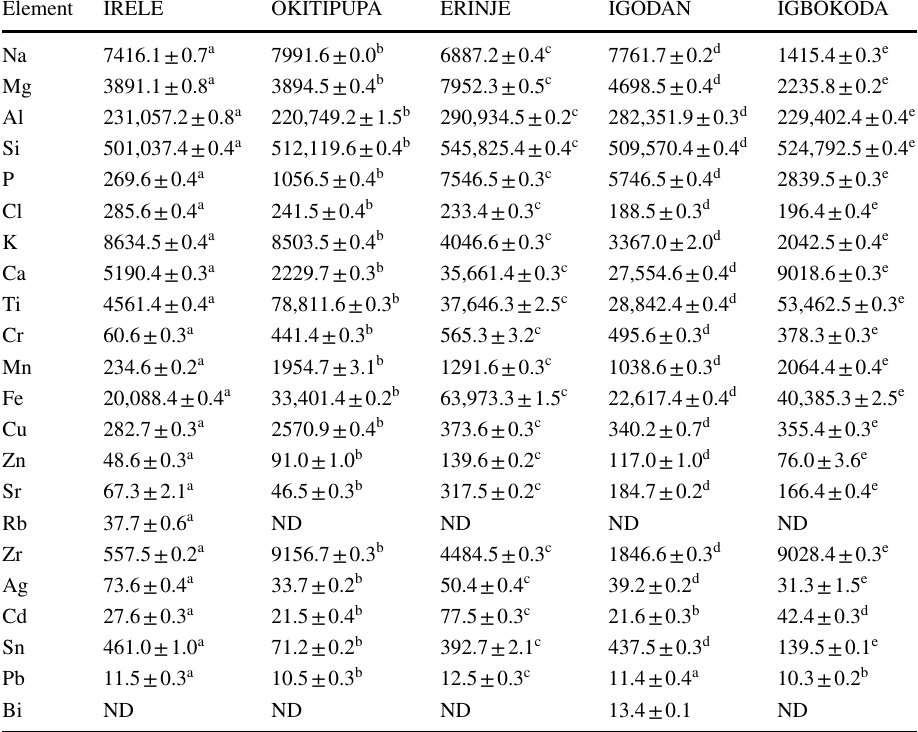
concentration (mg kg −1 ) and some physiochemical parameters of the various